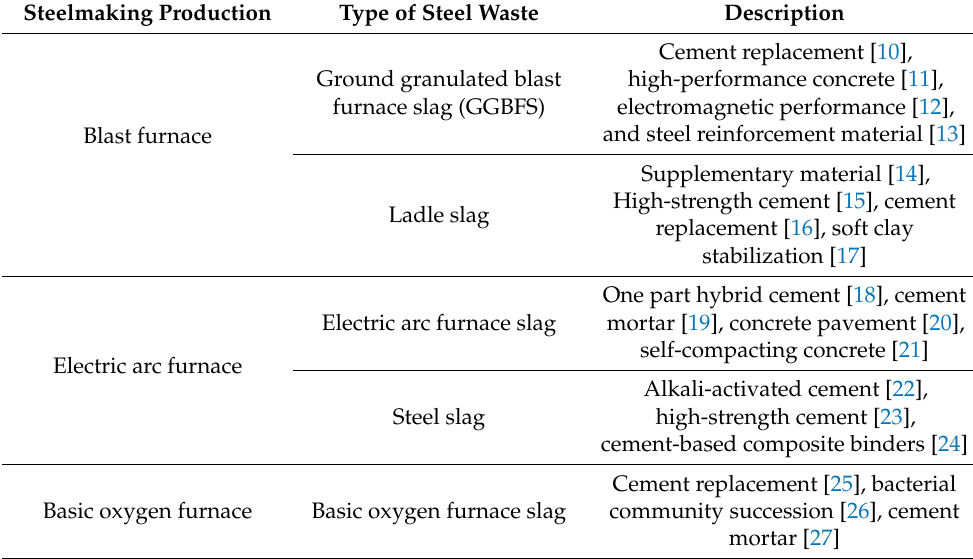
Table 1. Type of steel waste from different types of steelmaking production. Steelmaking